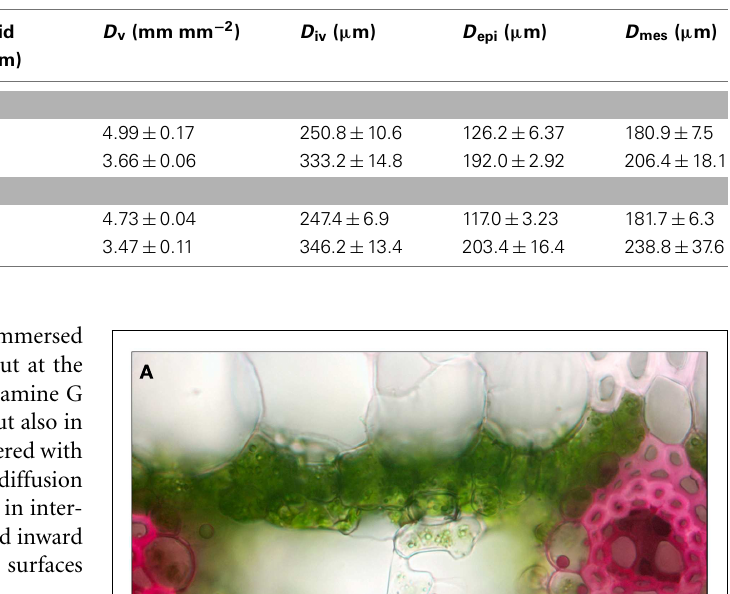
Table 3 |Anatomical traits for leaves of G. lingulata .